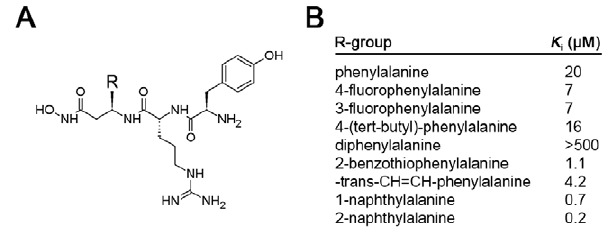
Figure 2. IDE inhibition by a focused library of retro-inverso peptide hydroxamates containing modifications at the P 1 ’ position. A , Structure of compound library. Note that compounds were generated in the retro-inverso configuration (see Fig. S2). B , Relative K i values of inhibitors containing different R groups (see A ).